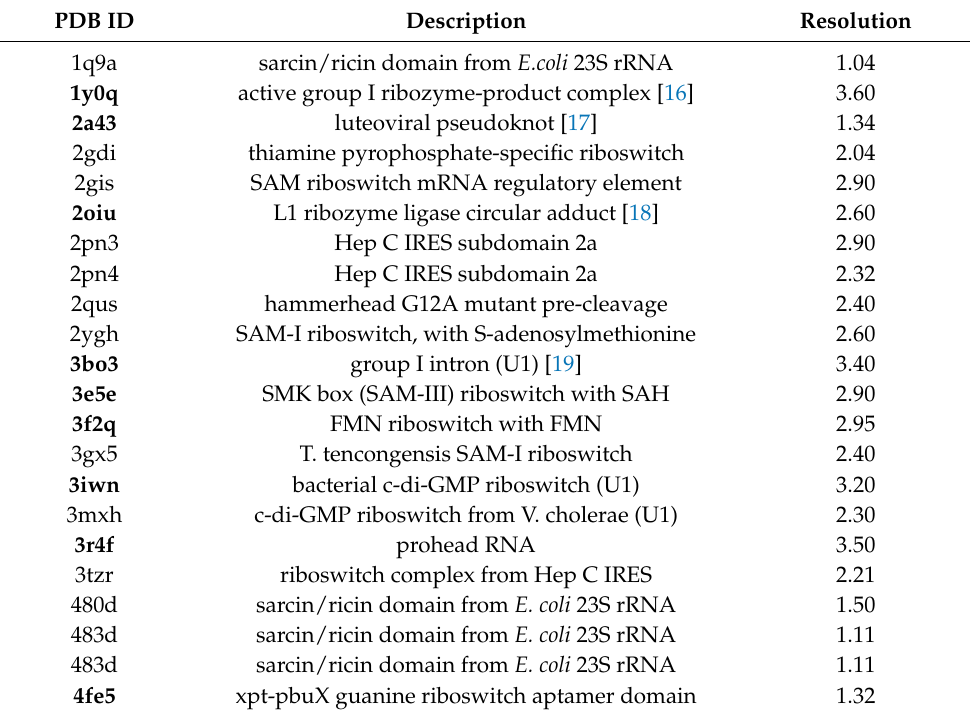
Table 1. Structures considered here. “U1” indicates the presence of the small nuclear protein U1. Structures in bold were also refined using a 3D-RISM implicit solvent model. PDB